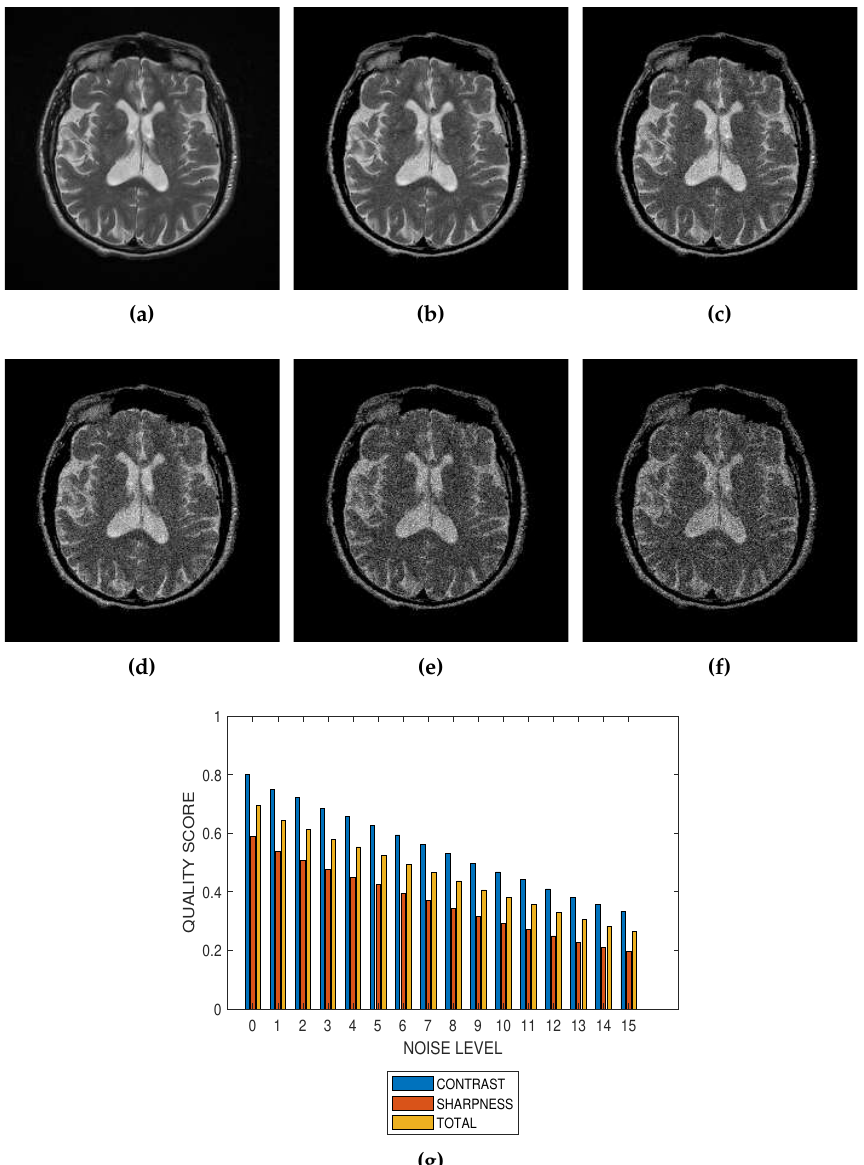
Figure 6. ( a ) A T2 weighted MRI slice from ADNI and its degraded versions at Rician noise levels ( b ) 3 percent, ( c ) 6 percent, ( d ) 9 percent, ( e ) 12 percent and ( f ) 15 percent. ( g ) Variation of contrast, sharpness and total quality scores for Rician noise levels that vary from 0 percent to 15 percent. Performance of the noise reduction algorithm at 4 percent, 8 percent and 12 percent noise levels are displayed in Figures 7–9, respectively. In the three levels of Rician noise, the post processing quality scores are higher than corresponding preprocessing quality